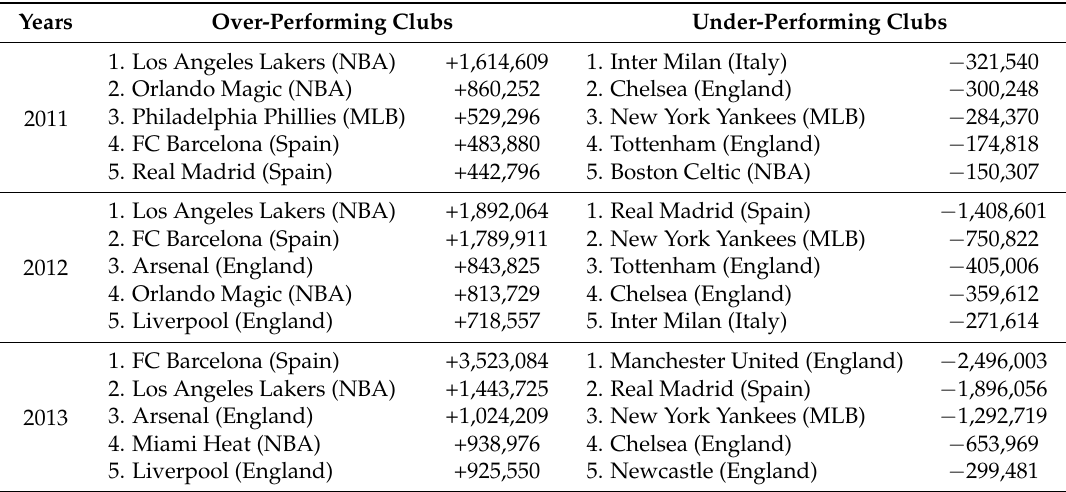
Table 4. Over- and under-performing clubs on Twitter in absolute